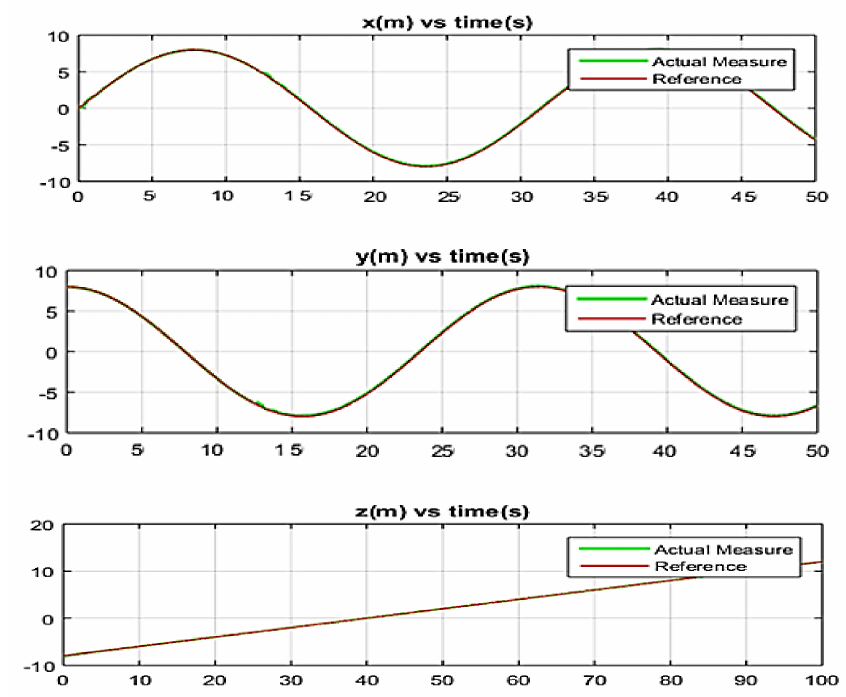
Figure 5. Positional Responses by Backstepping Control under no disturbances.